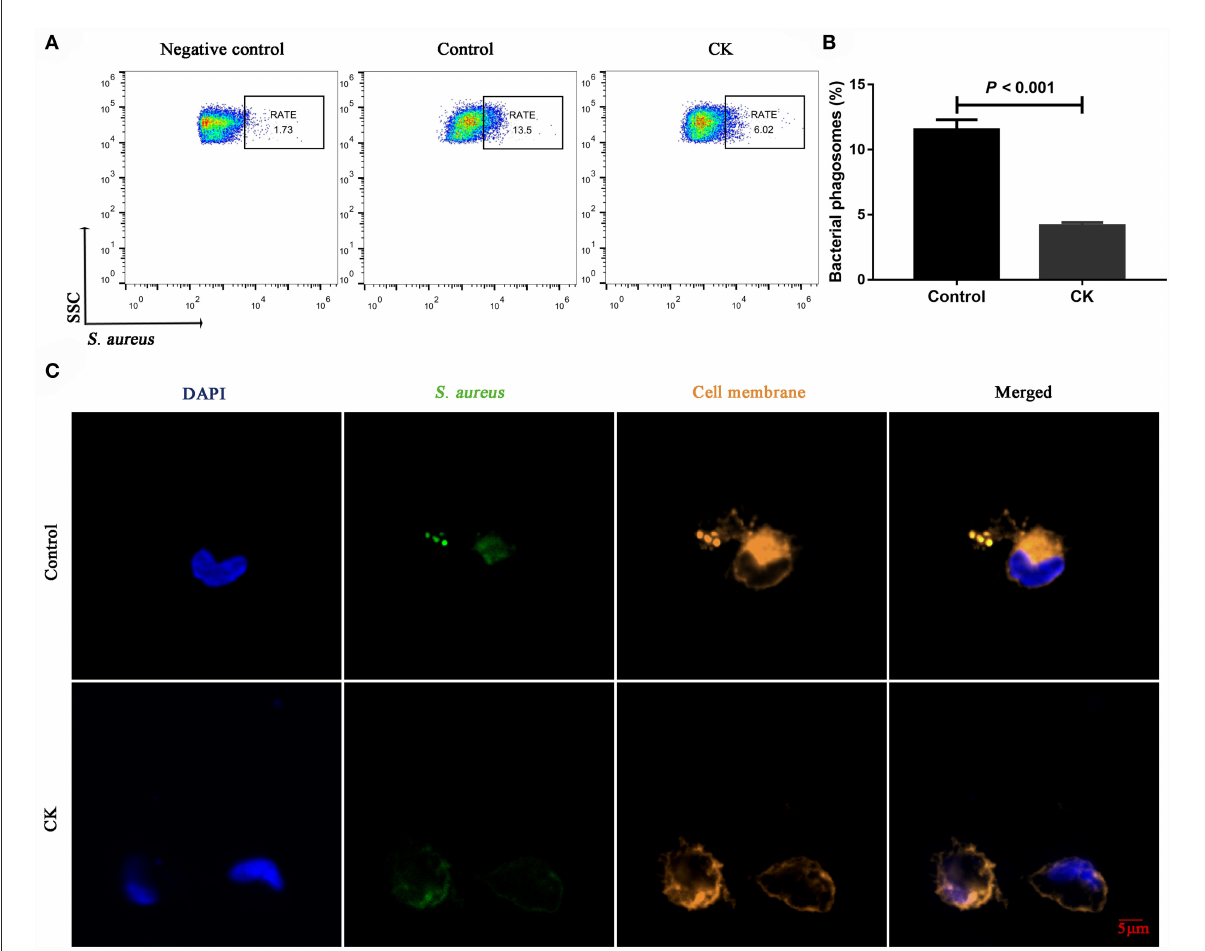
FIGURE2 Phagocytosis of CD14 + monocytes in healthy cows ( n = 12), and clinically ketotic cows (CK, n = 12). (A,B) Phagocytosis of monocytes, RATE, proportion of positive cells in 10,000 cells. (C) Representative images of Staphylococcus aureus (green) and cell membrane (orange), scale bar = 5 µ m. Data were analyzed with paired t -tests and reported as means ± SEM of three independent